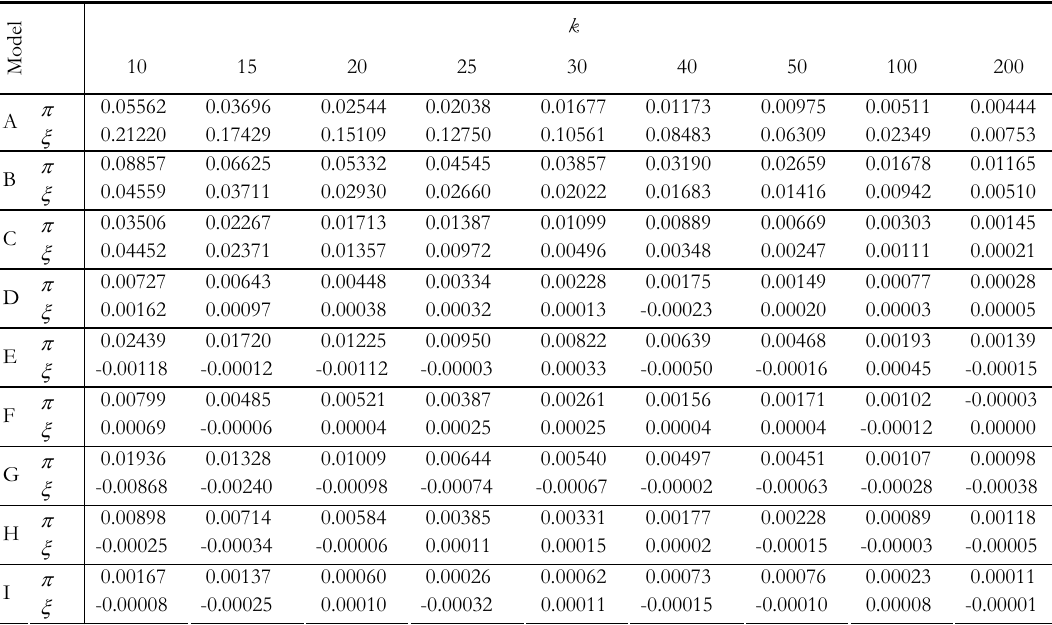
Bias of the ML estimators for (cid:83) and (cid:91)